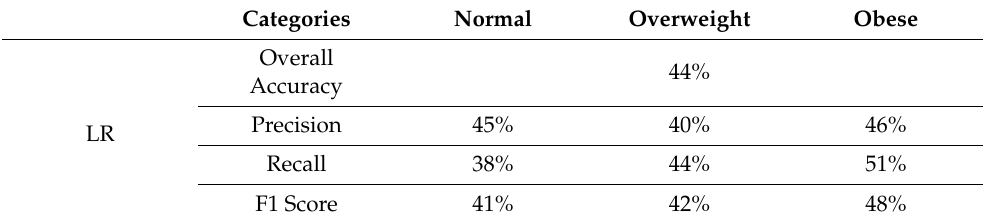
Table 7. Performance evaluations of ML techniques for determining obesity category based on early visits on a balanced